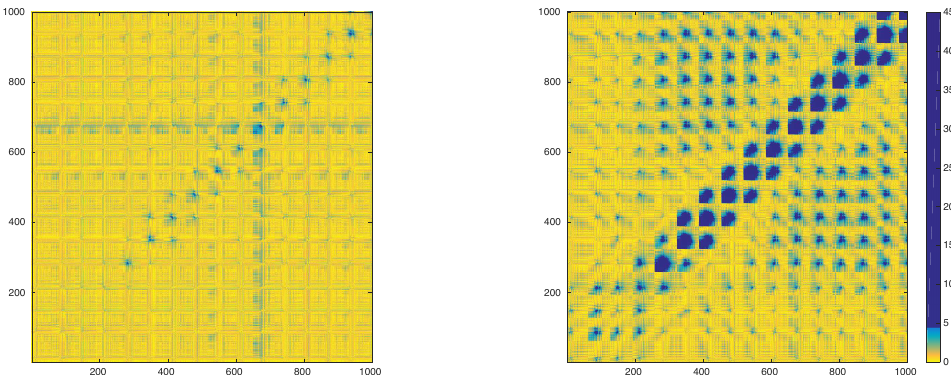
Figure 11: Non-specific bivariate leakage detection test on 15 clock cycles of a first-order protected AES. Left: 1 million traces. Right: 45 million